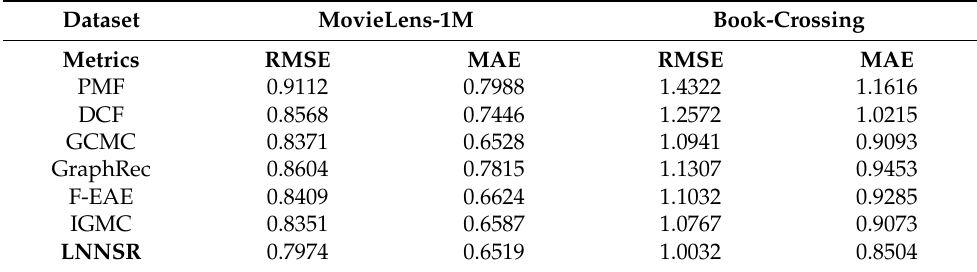
Table 2. Performance comparison of different recommender